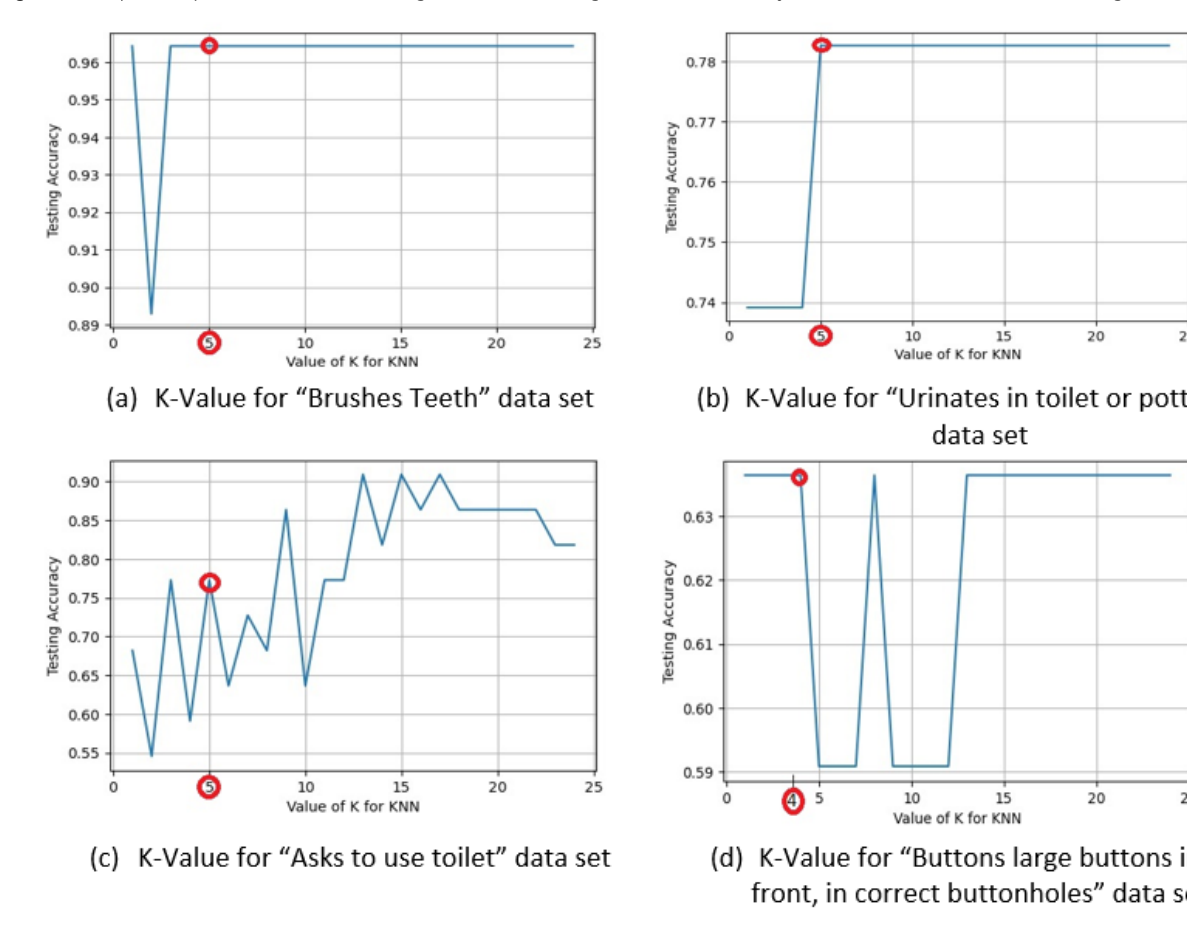
Figure 3. Graphical representation for calculating the best K- value against the test accuracy for the datasets. KNN: K-Nearest